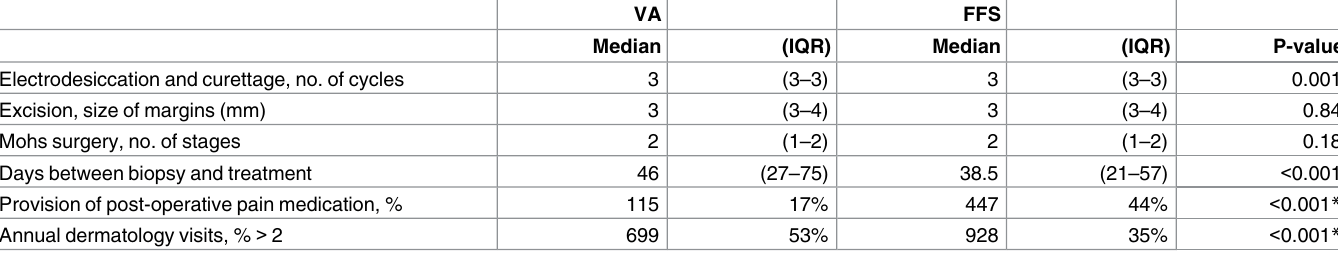
Table 2. Processes of Care.